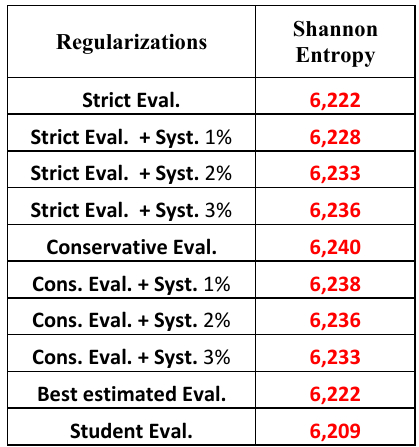
Table 1. Shannon entropies associated to the different evaluations.